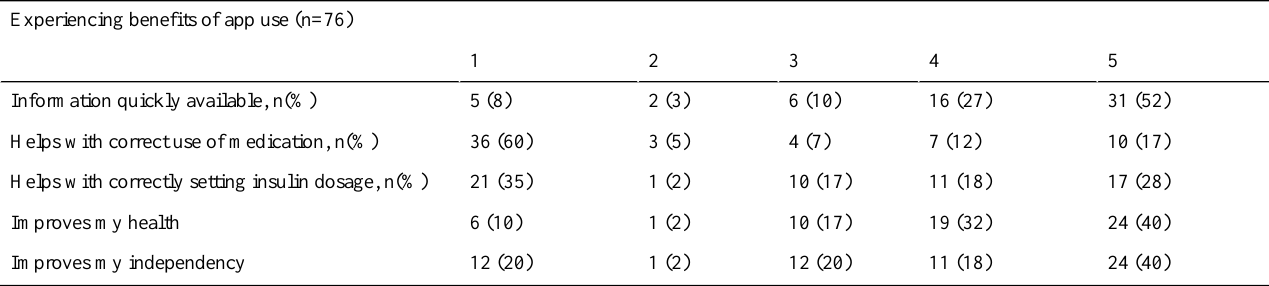
Table 5. Benefits experienced by use of apps for regulation of blood glucose levels. Experiencing benefits 1. Experiencing benefits of app use (n=76)